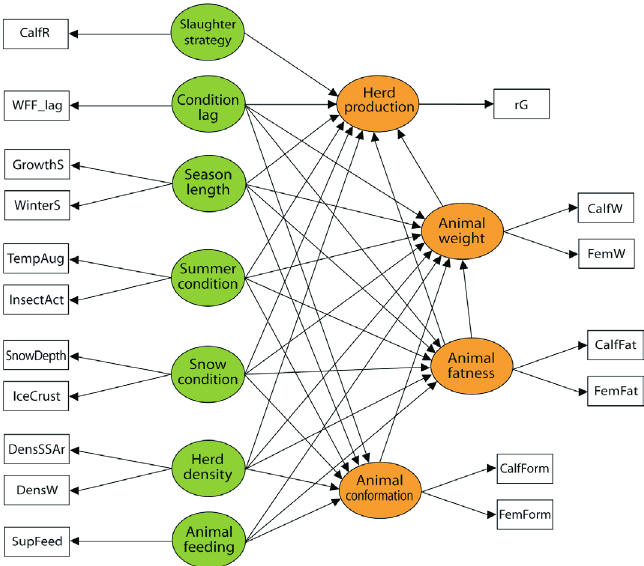
Fig. 3. Proposed structural equation model used to explore the re- lationship structure between environmental, constructed latent and productivity variables, within reindeer herding districts (focus on interannual variation). Measured manifest variables are showed in white, exogenous explanatory latent variables in green and endog- enous productivity latent variables in orange.